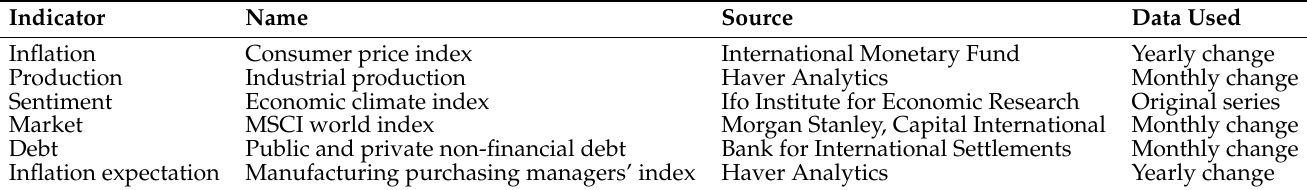
Figure 5. Performances of six global economic indicators from 2004 to 2017. Table 2. Global economic indicators and sources used in this